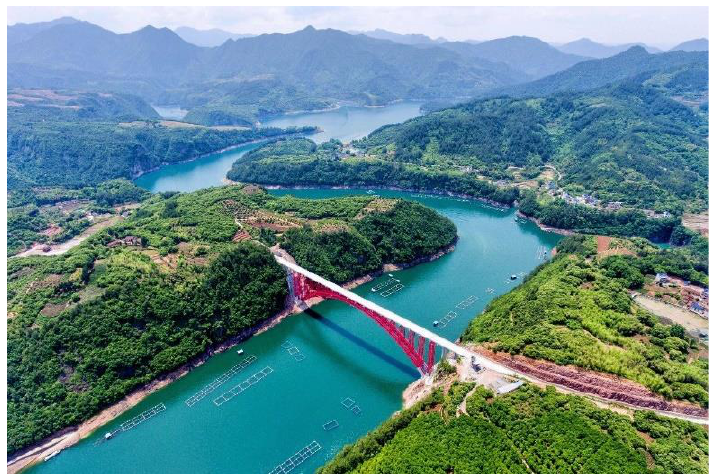
Figure 8. Aerial view of Hongxing village in Zhejiang province.